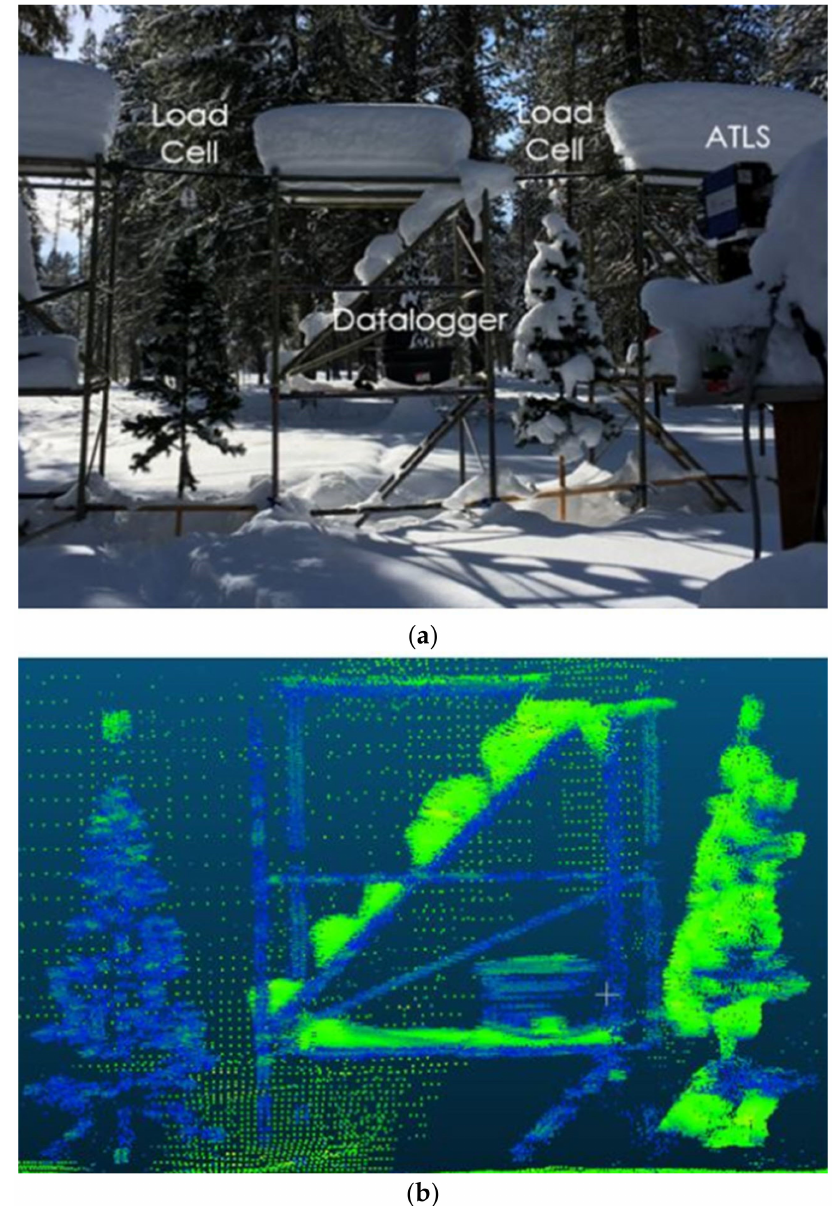
Figure 1. ( a ). Study site showing duplicate model trees hanging from load cells, datalogger, and automated terrestrial laser scanner (ATLS; see Eitel et al., 2013). “Left tree” to left of image with snow removed for illustration; “right tree” to right of image. ( b ). Scan of the trees on the same